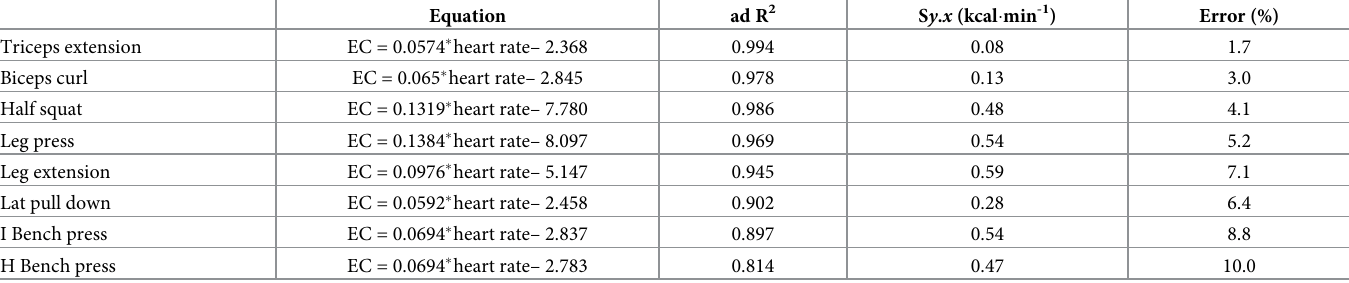
Table 1. Prediction equation, adjusted coefficient of determination (ad R 2 ), standard error of the regression (S y . x ) and relative error for energy cost prediction at 24% 1-RM in the eight exercises.